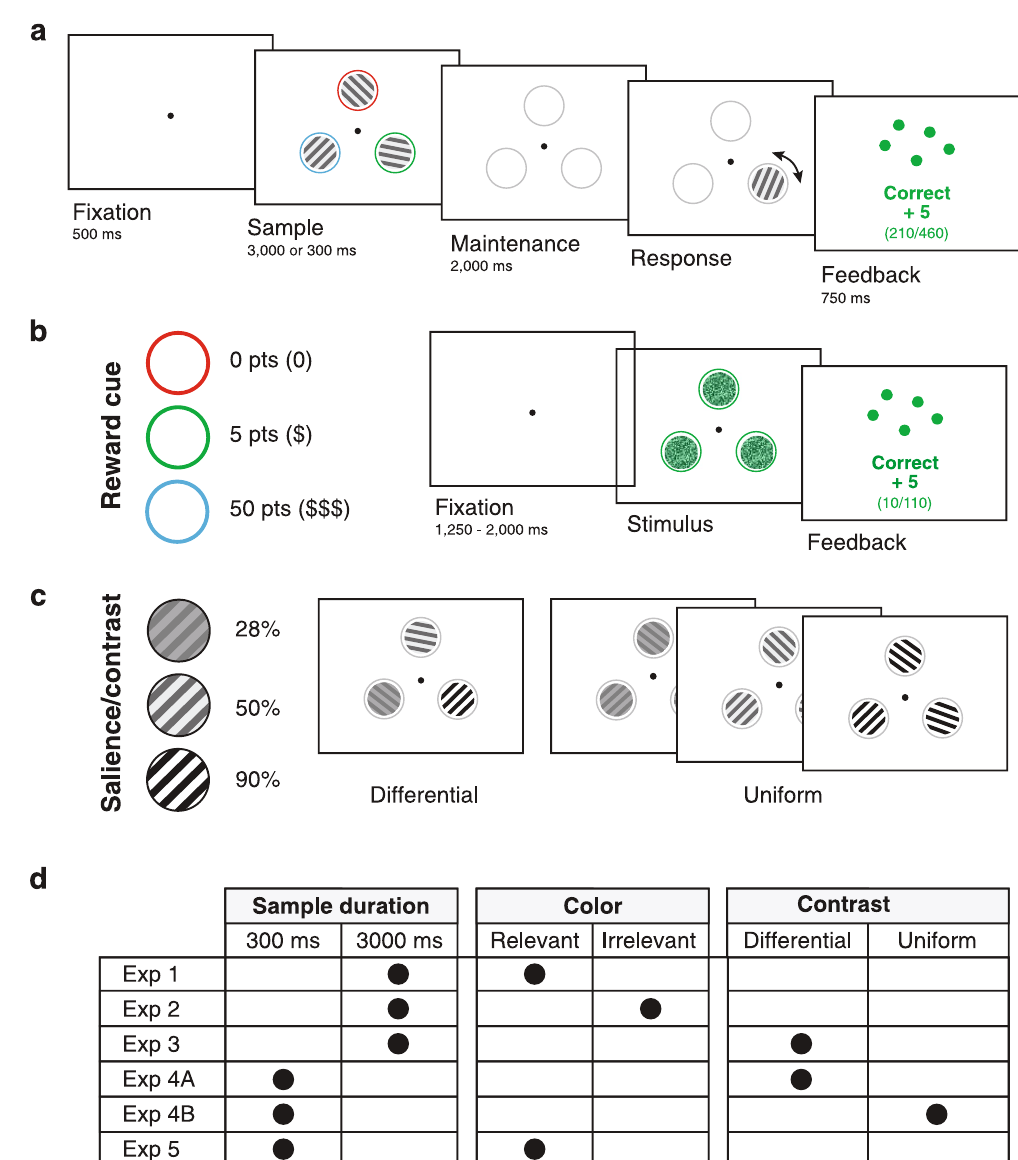
Figure 1. Experimental Design. ( a ) Working memory paradigm (schematic, in reality gratings were Gabors and background was gray). Trials started with 500 ms of fixation, followed by a Sample phase (3,000 ms in Experiments 1, 2, and 3; 300 ms in Experiments 4 and 5) in which three oriented Gabor patches were displayed (drawn here schematically as square wave gratings), surrounded by colored rings that were used as reward prediction cues in Experiments 1, 2, and 5. Participants remembered the orientations of the Gabors during a 2,000 ms memory maintenance phase and adjusted the orientation of a randomly selected target to match the memorized orientation in the Response phase. Feedback was provided about performance on each trial. ( b ) In Experiments 1, 2, and 5, the color of the rings around the targets was associated with a specific reward level (valid predictors in Experiments 1 and 5; no predictive value in Experiment 2). The participants first learned the association between color and reward level in a separate color-reward association task (right panel) in which they reported the color of three visual targets as quickly as possible. Feedback was provided about performance after every trial. ( c ) In Experiments 3 and 4, the contrast of the Gabors was manipulated to modulate the targets’ salience. In Experiments 3 and 4A the three targets differed in contrasts. In Experiment 4B all targets had the same contrast but the contrast level was varied across trials. ( d ) An overview of the different Experiments and their crucial parameters. Differences among experiments concern the duration of the sample phase, the presence and relevance of colored rings, and the presence and type of contrast